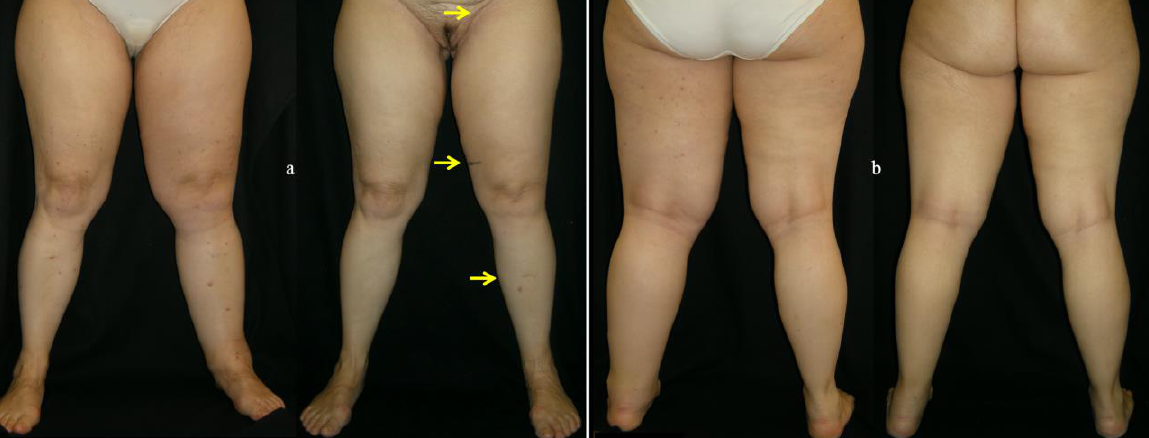
Figure 3. This figure shows anterior and posterior views of a patient affected by early-stage left LEL after PL for gynecological cancer, undergone Lympaticovenular Anastomosis (LVA), before and after surgery. ( a ) Anterior view of the patient before and after LVA was performed in the left lower limb. The yellow arrows indicate the sites where LVA was performed. After surgery, the improvement of swelling involves the whole limb; ( b ) posterior view of the same patient before and after surgery.